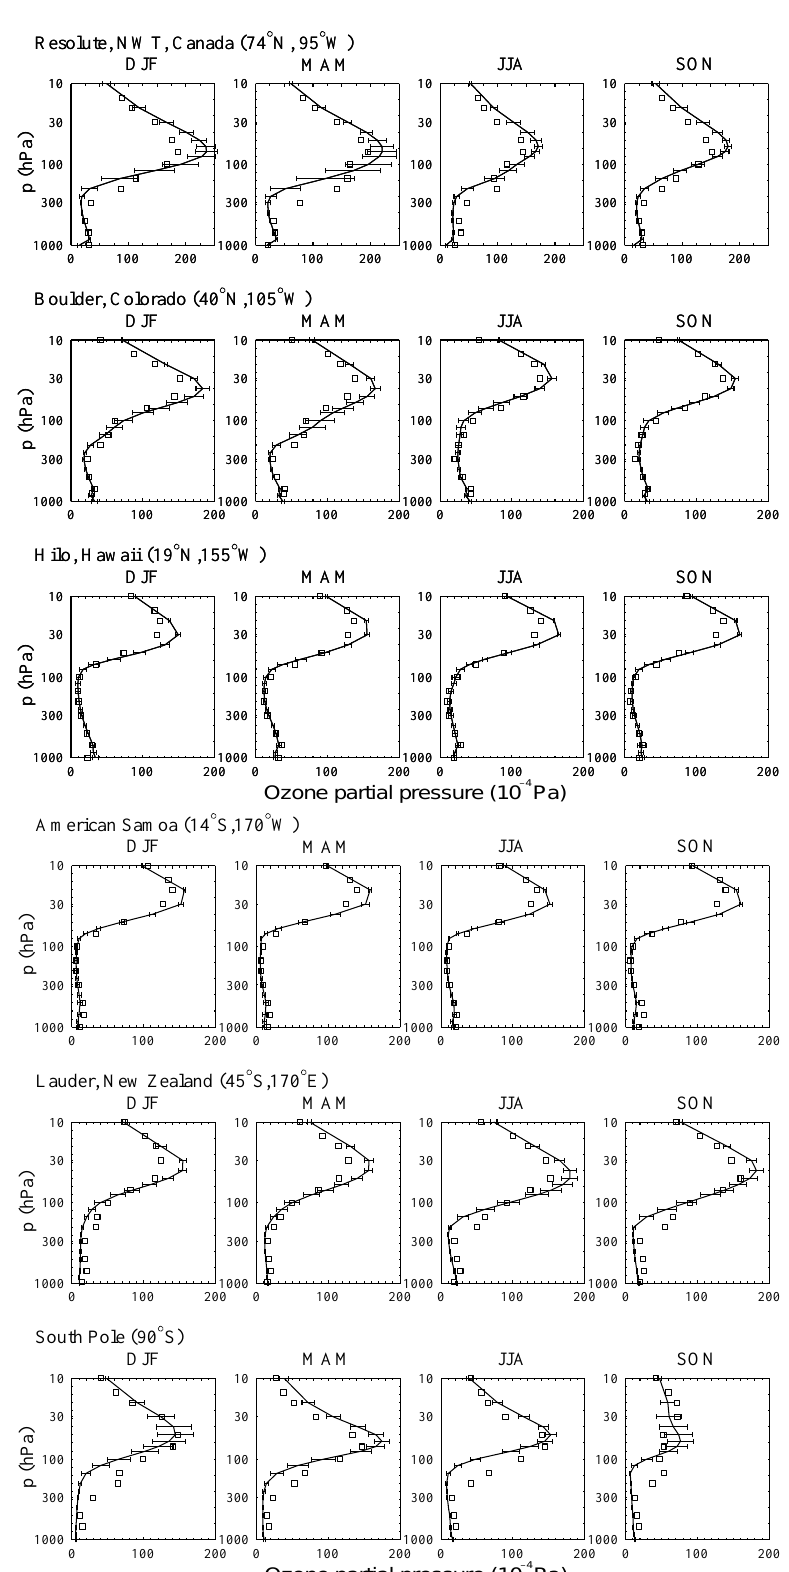
Fig. 9. Modeled (lines) versus observed (squares, Komhyr et al., 1989; Oltmans et al., 1989) climatological ozone profiles at selected stations for the four seasons. Horizontal bars indicate modeled interannual variability (two standard deviations). Observations have been taken from 1983 to